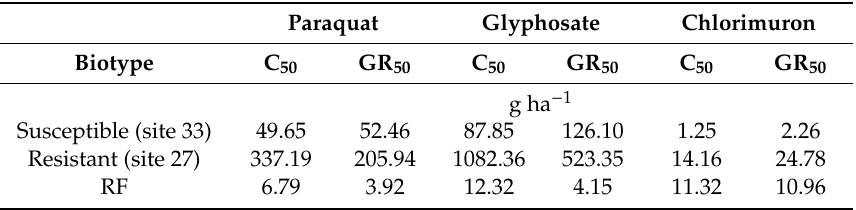
Figure 2. Control ( A ) and dry mass ( B ) of C. sumatrensis at 28 days after paraquat application. Control ( C ) and dry mass ( D ) of C. sumatrensis at 28 days after glyphosate application. Control ( E ) and dry mass ( F ) of C. sumatrensis (%) at 28 days after chlorimuron application. Site 27 (resistant to paraquat, glyphosate, and chlorimuron) and site 33 (susceptible). Bars shows the standard deviation (SD), n = 4. Table 4. TherequireddoseofherbicidesforC 50 (50%control)orGR 50 (50%growthreduction)andresistance factor (RF) for C. sumatrensis